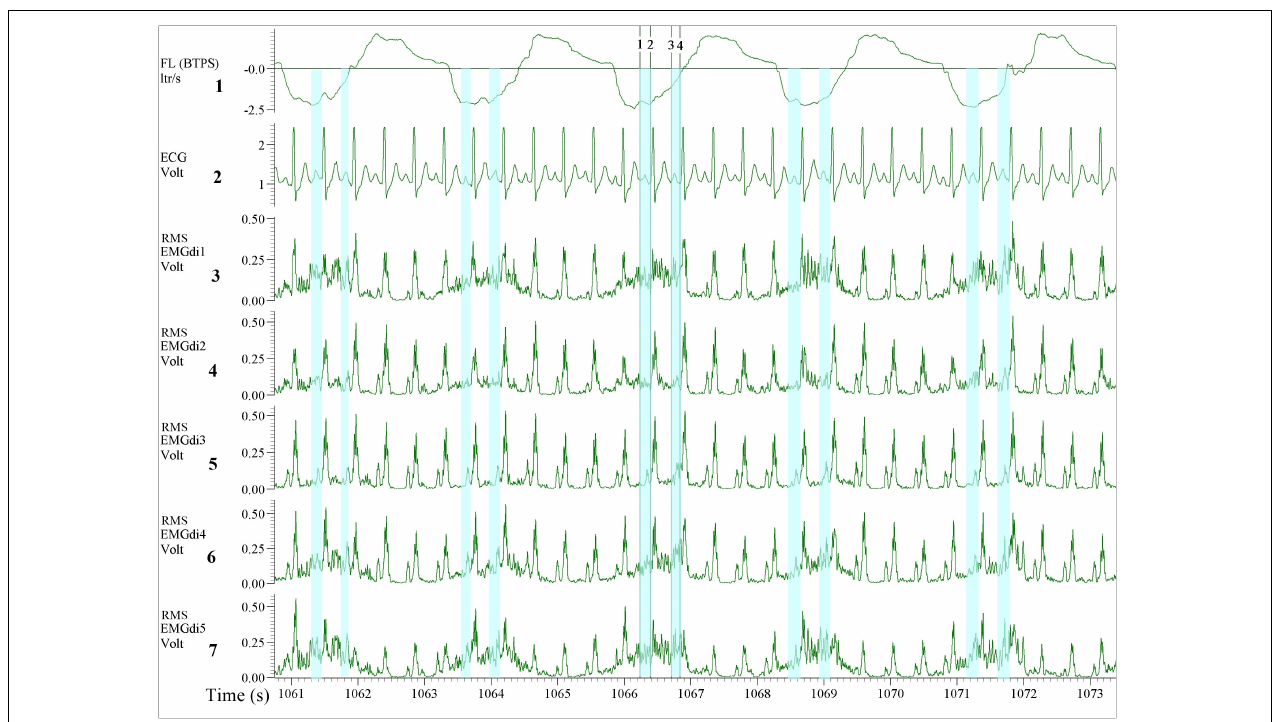
FIGURE 2 | Illustration of the diaphragm EMG (EMGdi) recordings toward the end of the (symptom limited) cycling test. Channel 1: respiratory flow (l/s; negative flow indicating the inspiratory cycle), Channel 2: electrocardiogram (ECG) recording (volt), Channels 3–7: RMS EMGdi recordings. For the data analysis using the manual method, the mean values of EMGdi in between QRS complexes during the inspiratory cycle were selected. The periods highlighted in light blue are the possible periods that could be chosen without ECG contamination in each inspiratory cycle. The average of EMGdi of five consecutive breaths was used as a representative value of EMGdi of that minute. Vertical cursors 1, 2, 3, and 4 were used as a tool during manual analysis to retrieve mean values of EMGdi in the selected period.